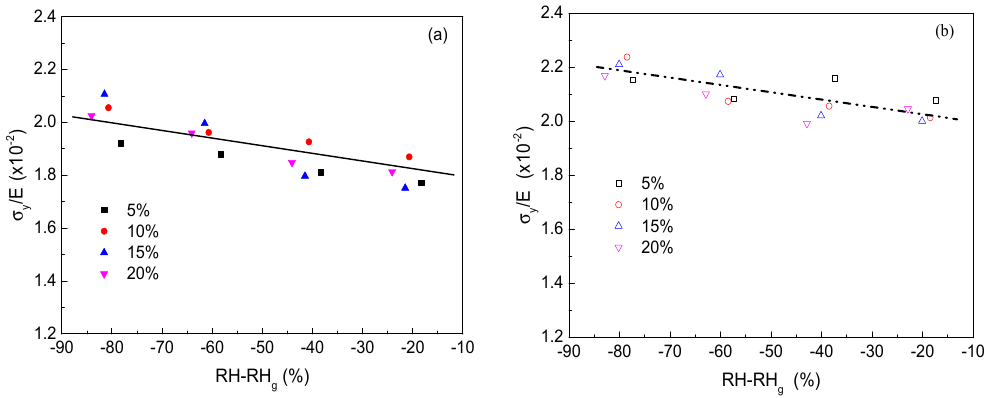
Figure 5. Evolution of yield stress normalized by the elastic modulus ( σ y / E ) versus RH-RH g for cured film at different cross-linker content ( a ) xPVAc/EMDI and ( b ) xPVAc/p-MDI.